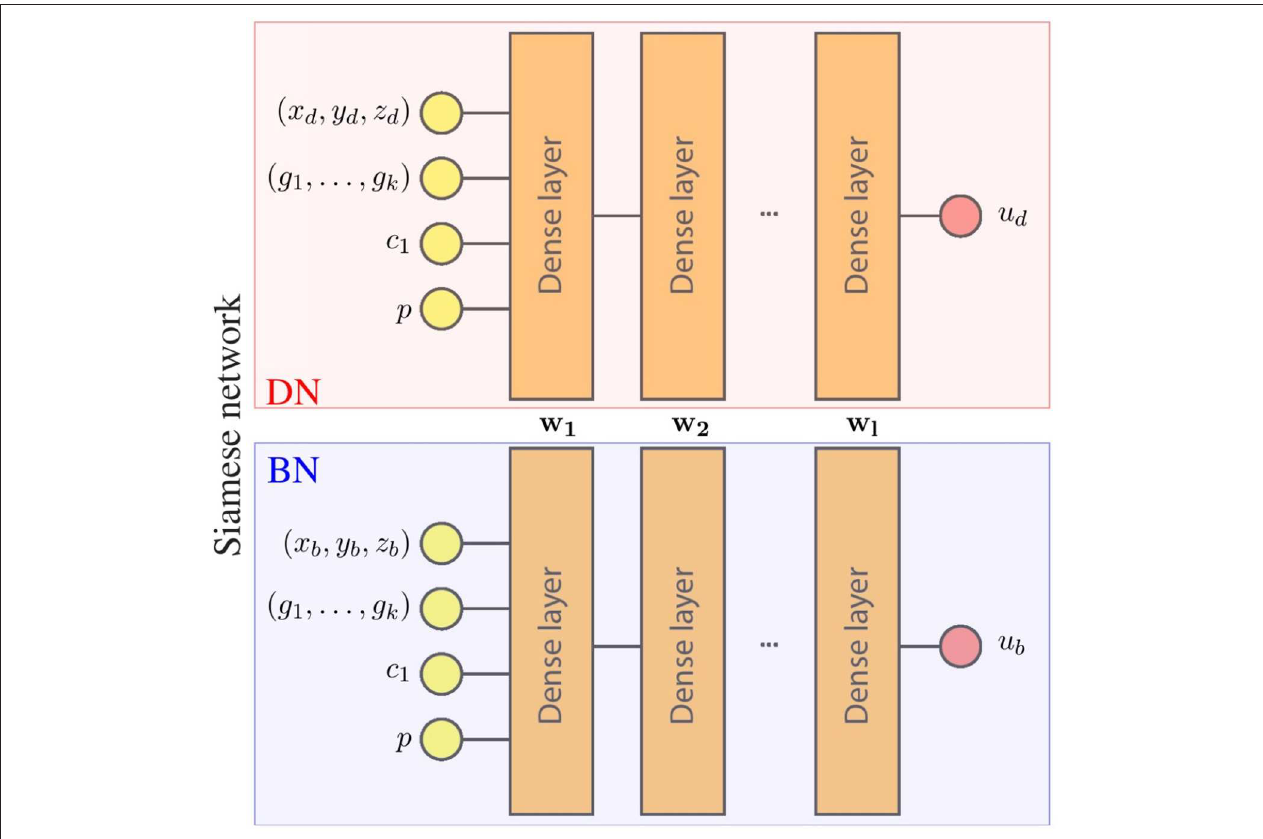
FIGURE 1 | Surrogate network architecture for one component of the displacement field. w i represents parameters of the i -th layer that are the shared by the boundary network (BN) and the domain network (DN). During training, both networks optimize these shared parameters with different data, leading to a single network with parameters w 1 , ... , w l that meet the conditions of both networks (boundary and domain { }